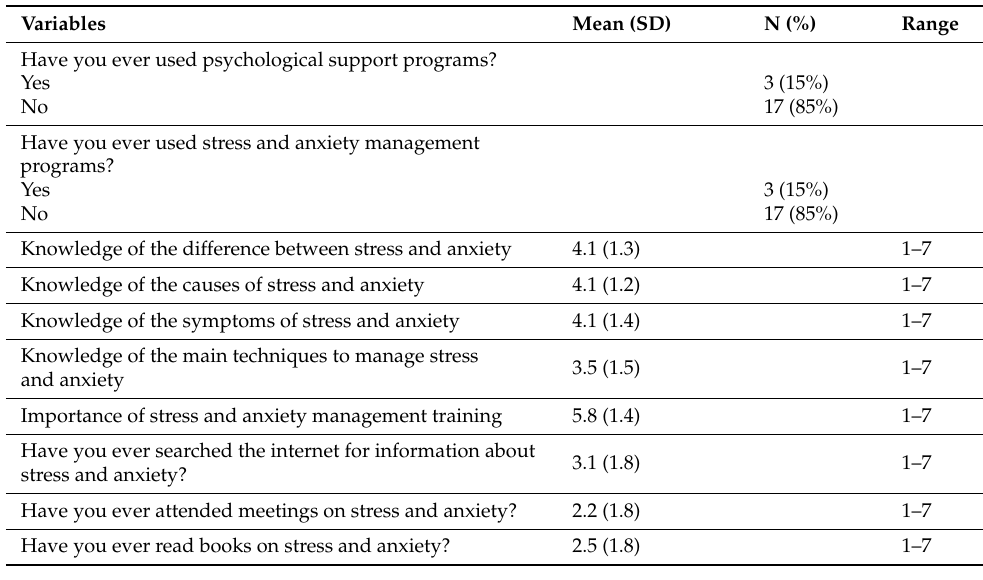
Table 2. Background knowledge of stress and anxiety in the sample (N =